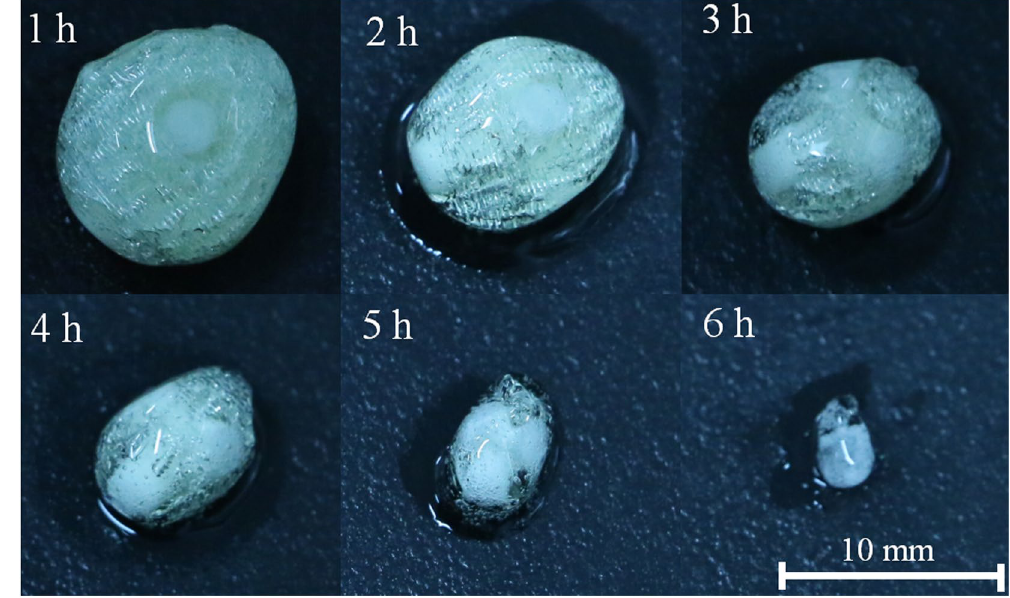
Figure 6. Tablets with Cylinder model during